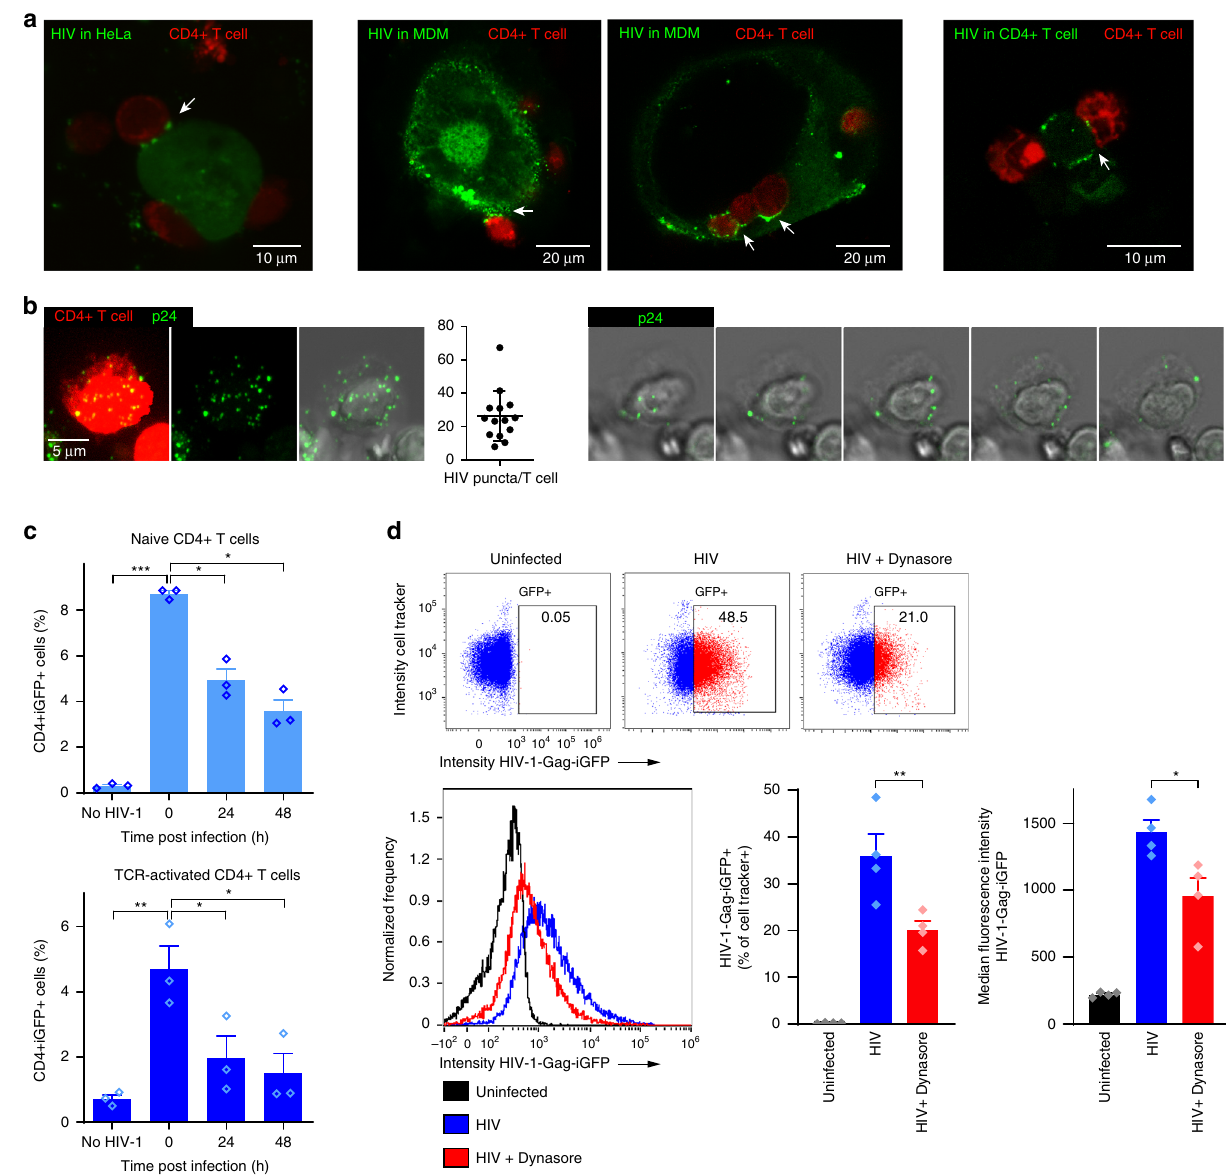
Fig. 1 HIV-1 is endocytosed and degraded by CD4 + T cells. a HeLa cells expressing X4-tropic HIV-1-Gag-iGFP (green), primary human monocyte-derived macrophages (MDM) infected with cell-free HIV-1-Gag-iGFP_JRFL (R5 HIV-1), or primary CD4 + T cells infected with cell-free HIV-1-Gag-iGFP (X4 HIV-1) were co-cultured for 3 h with TCR-activated CD4 + T cells (Cell Tracker Deep Red) in the presence of the CXCR4 inhibitor, AMD3100 or the CCR5 inhibitor, Maraviroc. HIV-1 is accumulating in the virological synapse between donor and acceptor cell for all tested donor cell types. b CD4 + T cells were co-cultured with HEK293T cells expressing NLENG1-IRES (X4 HIV-1) for 24 h, trypsin treated for removal of extracellular virus and labeled with antibodies against HIV-1 p24. Maximum intensity projection images of a representative CD4 + T cell (stained with Cell Tracker Deep Red, left image panel), and quanti fi cation of the number of trypsin-resistant HIV puncta (identi fi ed by p24 staining, green) per acceptor T cell. Slices from a confocal z- stack through the same cell depicting HIV puncta in trypsin-resistant compartments (right image panel, every second slice is shown). c Frequency of trypsinized HIV-1- positive CD4 + T cells after co-cultured for 3 h with HIV-1-Gag-iGFP-expressing HeLa cells, analyzed by fl ow cytometry 0, 24, and 48 h post co-culture. Bars represent mean + SEM from three independent experiments. d CD4 + T cells were pre-treated with 80 µ M Dynasore for 1 h prior to co-culture with HEK293T cells expressing HIV-1-Gag-iGFP (X4 HIV-1) for 24 h and analysis by imaging fl ow cytometry. Dot plot examples showing frequencies of trypsinized HIV-1-positive CD4 + T cells (top). Histogram overlay of median fl uorescent intensity of Gag-GFP (left) and quanti fi cation (right). Bars represent mean + SEM from four independent experiments. Statistical signi fi cance was determined from log-transformed data by repeated measures two- way ANOVA with Dunnett ʼ s post-test in c and two-tailed paired t -test in d ; signi fi cance levels: *p < 0.05; * *p < 0.01; ** *p < 0.001. Source data are provided as a Source Data